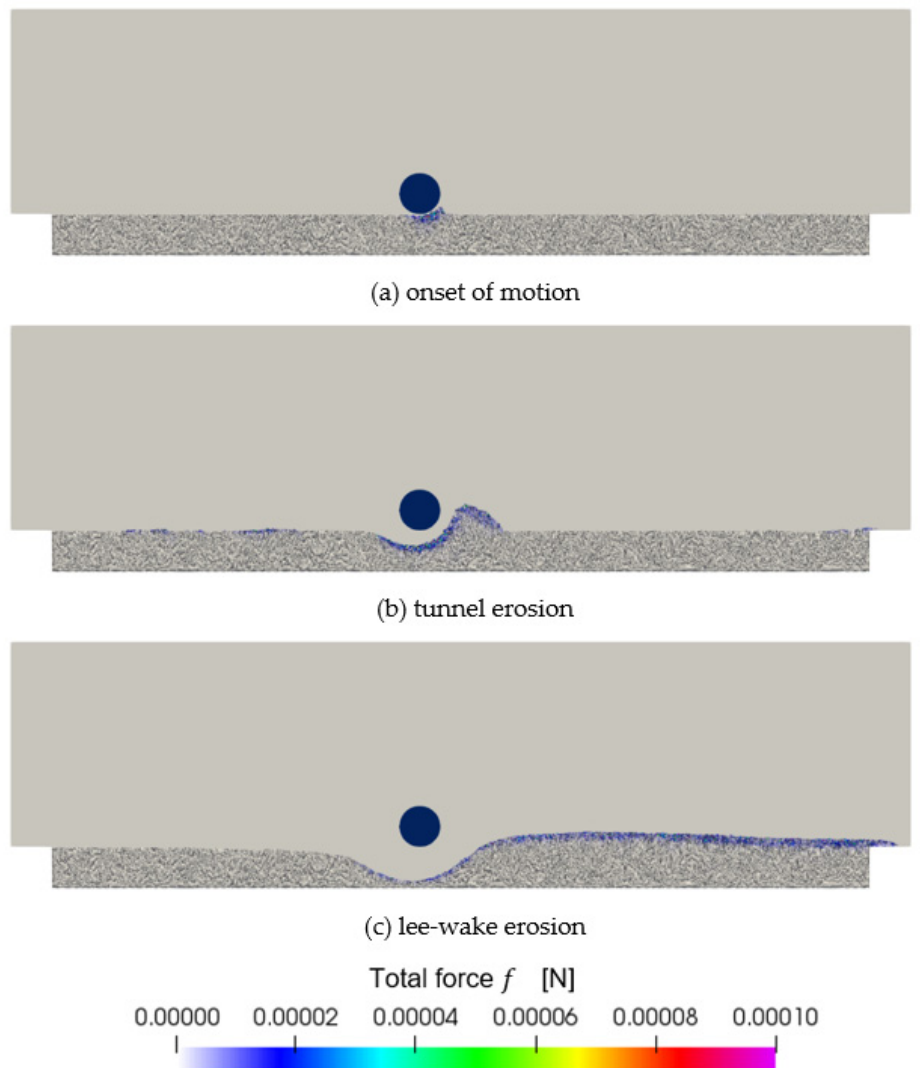
Figure 16. Total force distribution ( 𝑓 ).